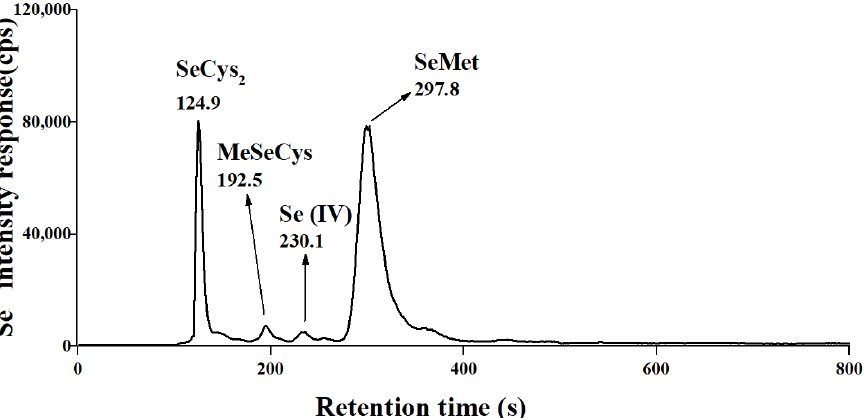
Figure 1. HPLC-ICP – MS chromatogram of Se species in SePP, Peak 1 = Selenocystine (SeCys 2 , 124.9 s); Peak 2 = Se-methylselenocysteine (MeSeCys, 192.5 s); Peak 3 = Se (IV) (230.1 s); Peak 4 = SeMet (297.8 s).